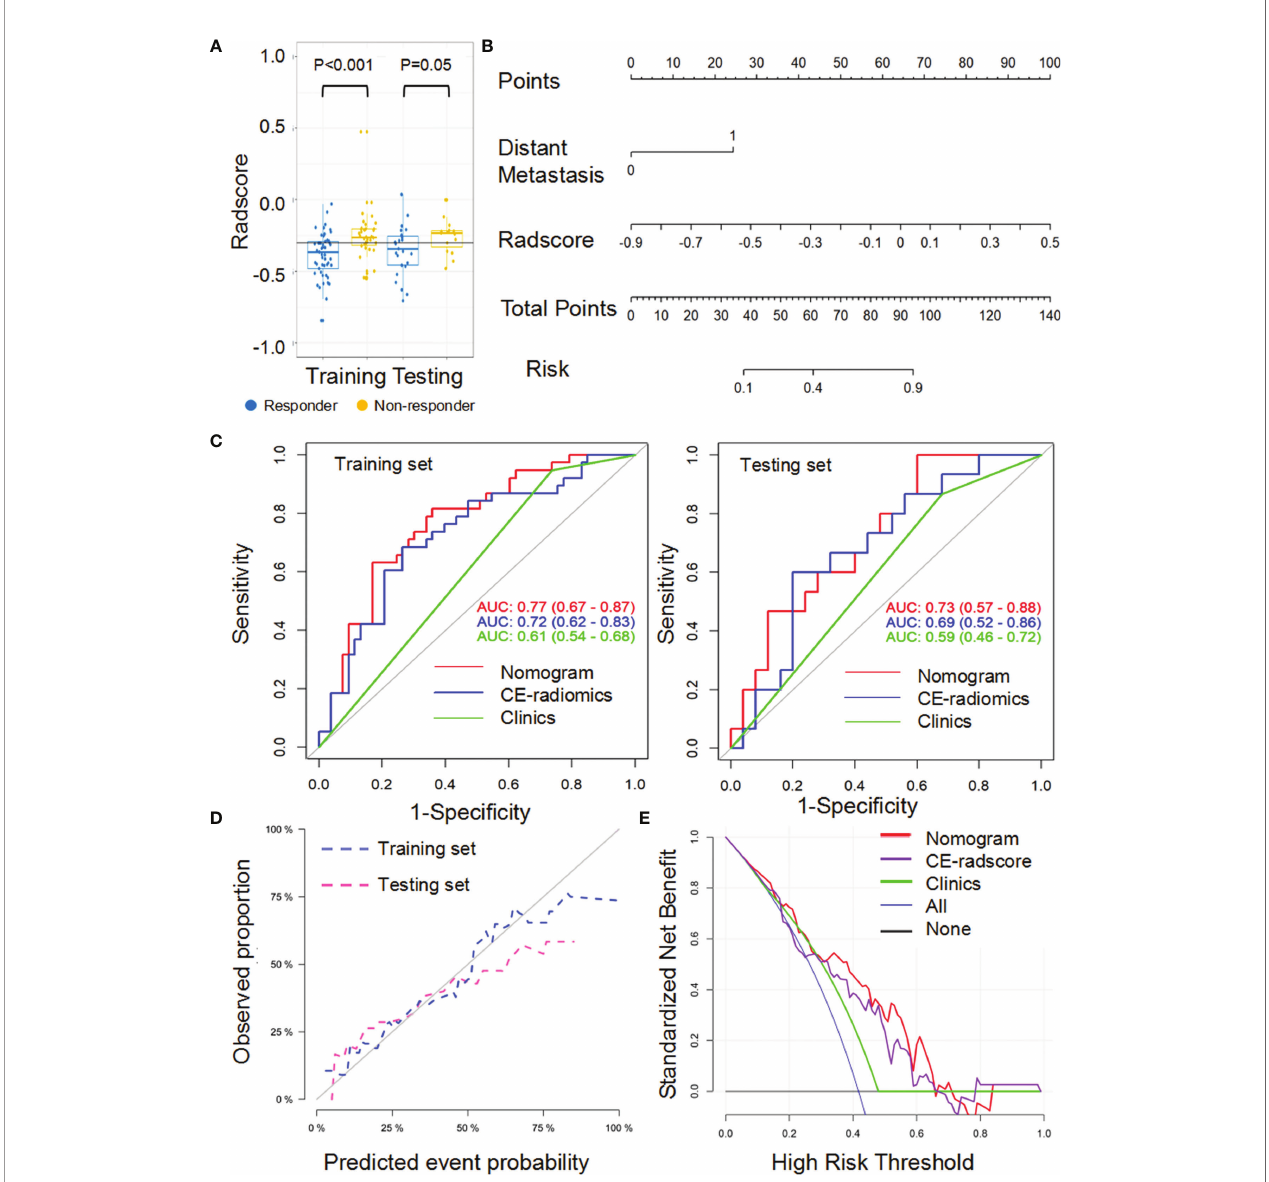
FIGURE 4 | Performance of the CE-radiomic signature from largest lesion approach in training and testing sets. (A) Box and whisker plots depict radscore comparison between responders and non-responders. (B) Radiomic nomogram developed in training set. (C) ROC curves of radiomics signatures in training and testing sets. (D) Calibration curve analysis for the nomogram in training set and testing set. (E) Decision curve analysis for the nomogram (red), radscore (purple), and clinical model (green). The y-axis indicates the net bene fi t; x-axis indicates threshold probability. The blue line represents the assumption that all patients were responders. The black line represents the hypothesis that no patients were